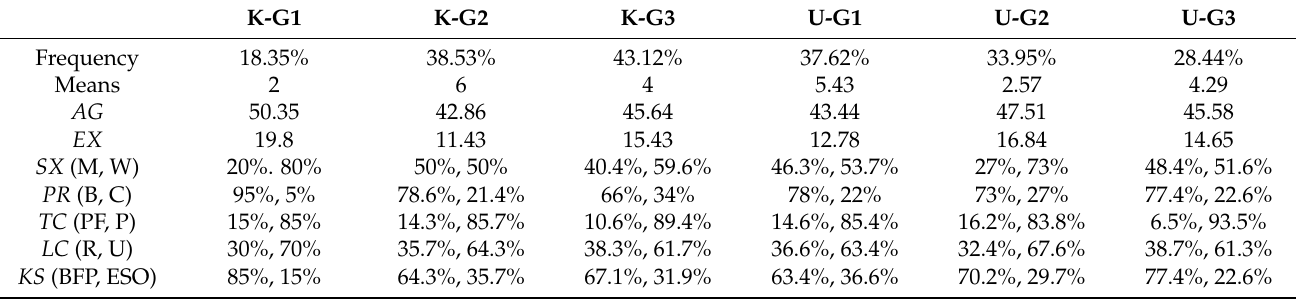
Table 12. Cluster groups as regards the knowledge and use of information access and management tools.